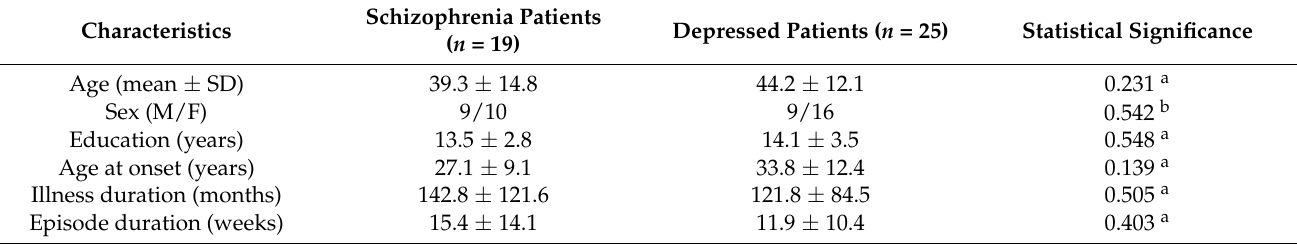
Table 1. Demographic and clinical characteristics of the participants.